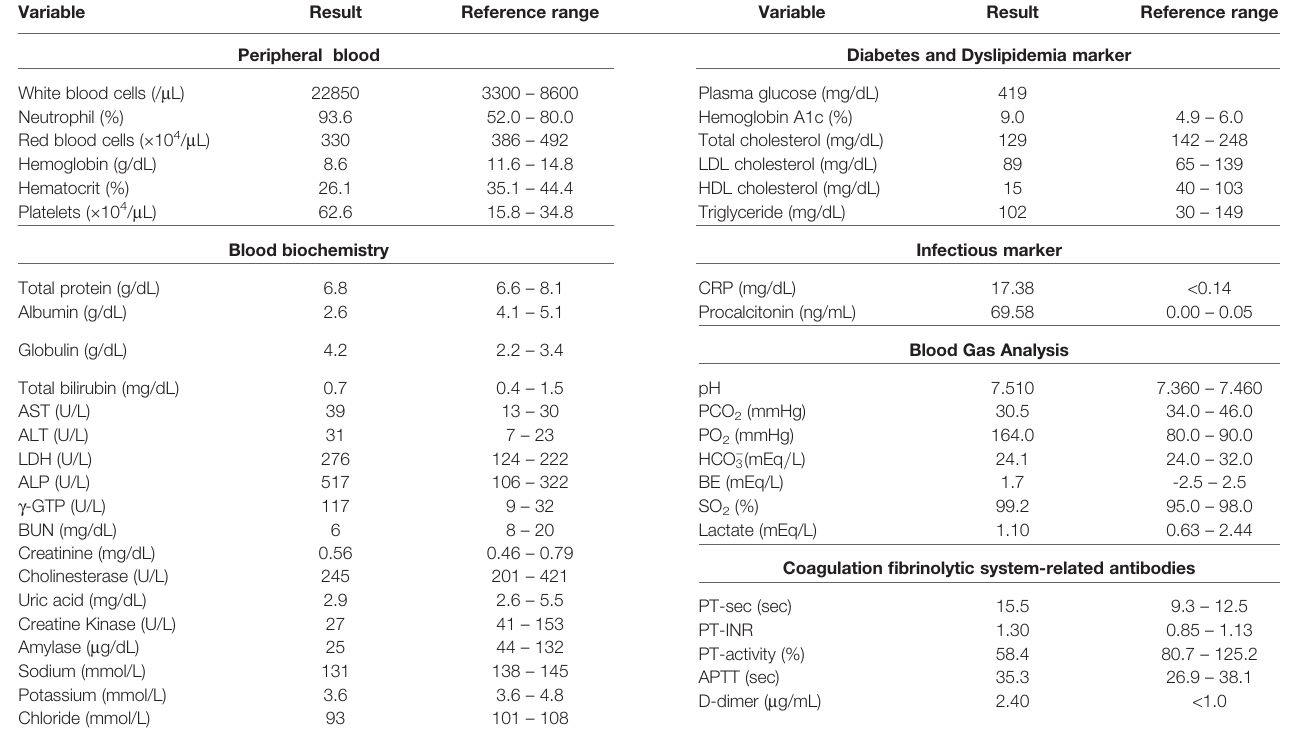
TABLE 1 | Laboratory data in an emergency room in this